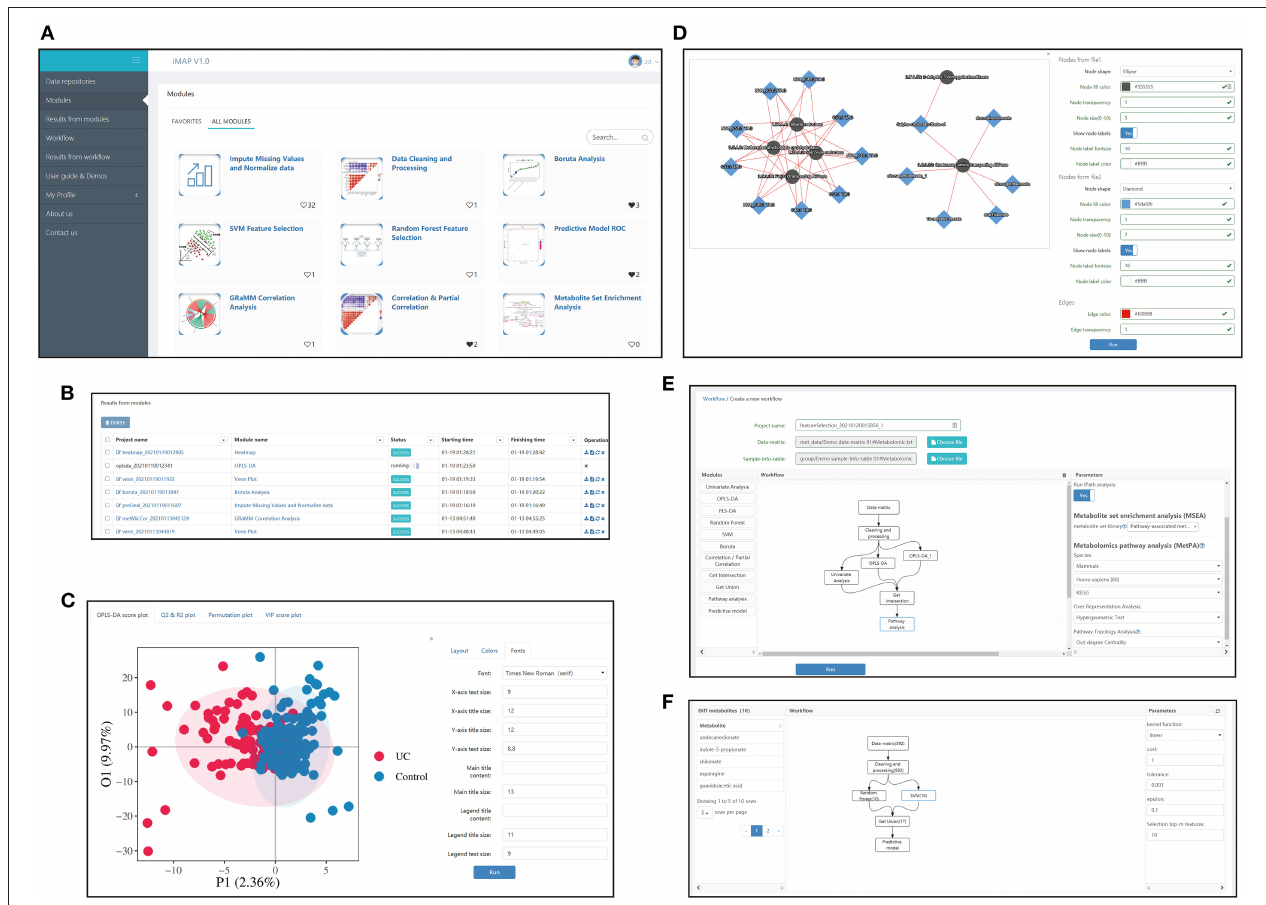
FIGURE 1 | Interfaces screenshots of iMAP. (A) The main menu and part of modules. The main menu lies on the left. And modules are shown on the right after clicking “Modules” in the main menu. Over 20 modules are available in iMAP at present. Click “User guide & Demos” to check detailed manuals. (B) The interface showing results from modules. Users can view detailed results, change parameters for visualization, download the results or rerun the module with modified parameters. Interface showing the results from workflows working in the same way. (C) Demonstration of the visual parameter in OPLS-DA result. Users can change parameters for layout (such as whether to show labels and confidence ellipse, picture size), choose colors, and adjust font parameters. (D) Demonstration of the visual parameter in a correlation-based network. All plot results from modules and workflows can be modified like the OPLS-DA results and the correlation-based network, designed to provided users with high-quality, publishable plots. (E) The workflow creation interface. After the data matrix and sample information table were chosen, modules in the left panel can be dragged into the center panel. Users can construct their customized workflow by connecting modules with arrows. Parameters can be modified in the right panel when a module was selected. (F) The interface of detailed workflow results. Users can see the workflow in the center panel. The number in brackets showed the count of the selected metabolites by each module. The selected module’s outline will turn blue like the “SVM” module in the center panel. Users can click on a module to check the parameters used in the right panel. Users can also click on the module and check the metabolites selected by that module on the left panel. The 10 metabolites selected by the SVM module, including undecanedionate, indoe-3-propionate, etc., were shown in the left